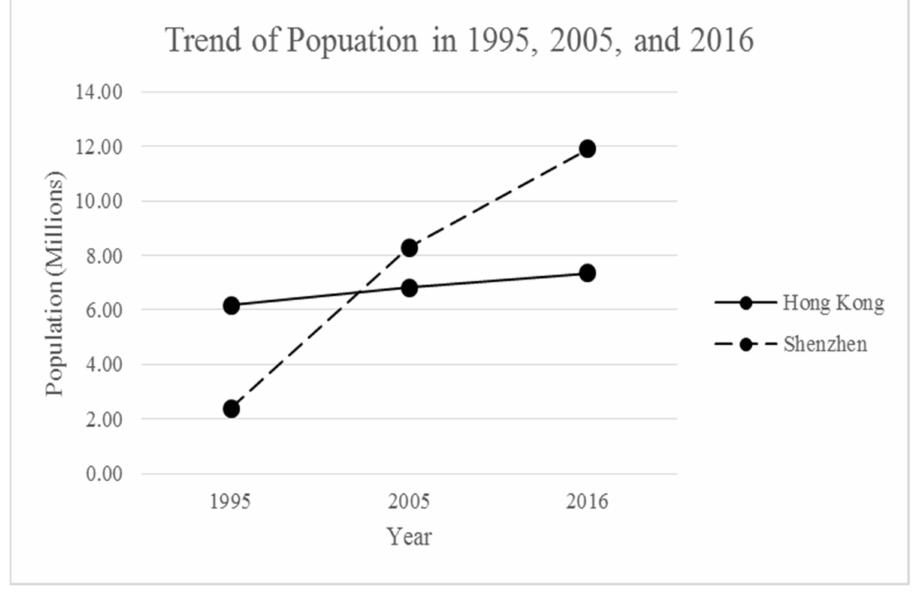
Figure 16. Trend of population in 1995, 2005, and 2016.